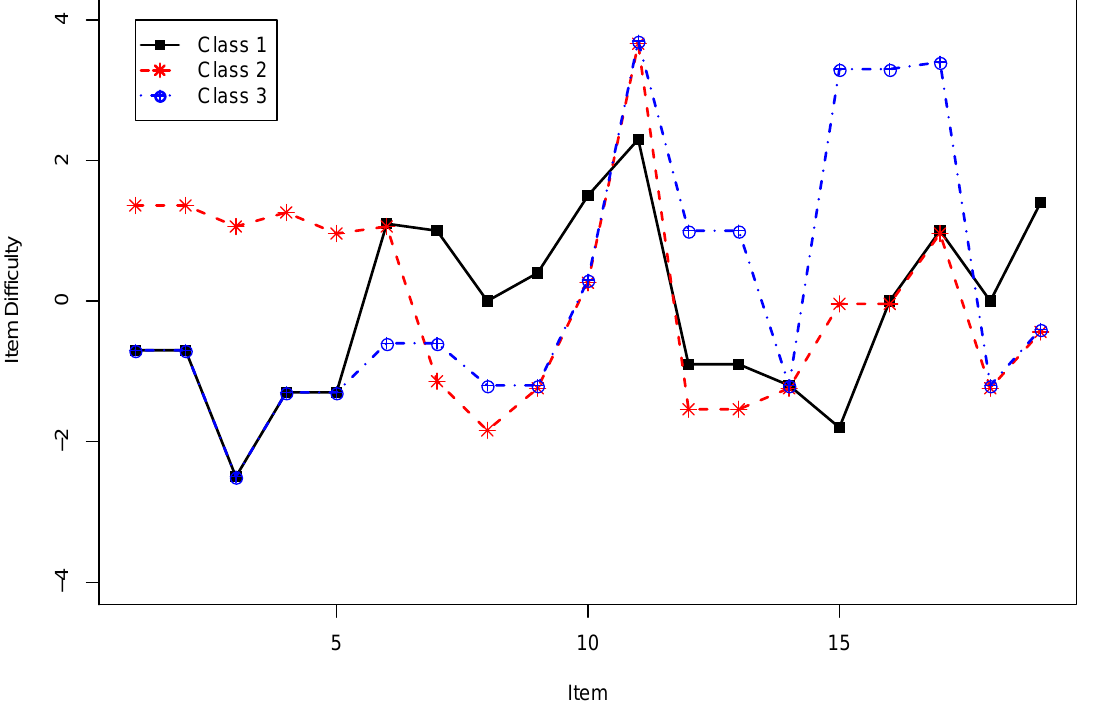
Figure 7. Simulated Case Study 3: True item difficulties b ic